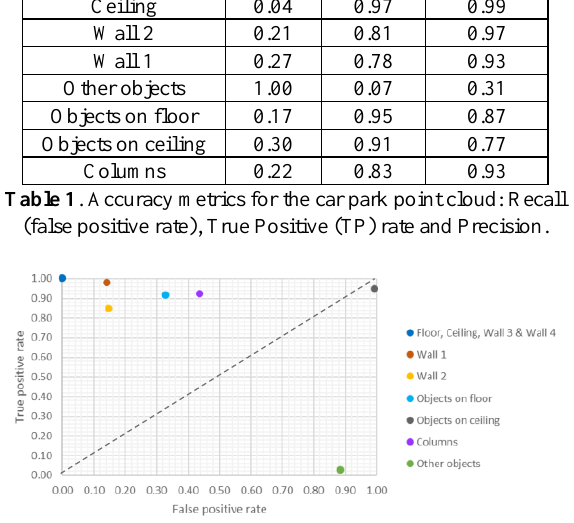
Figure 7. ROC graph for the office space point cloud.